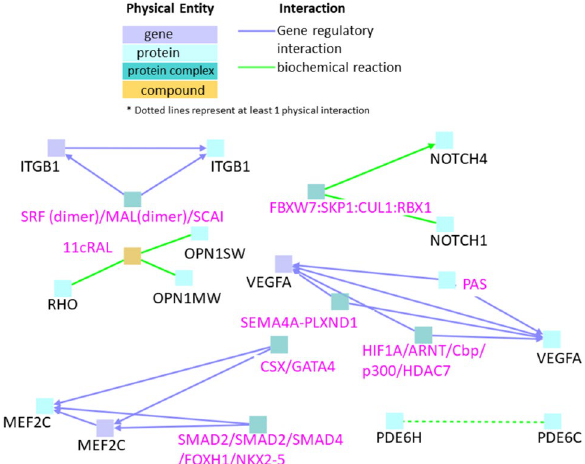
Figure 6. Interactions between genes that are downregulated exclusively in cardiotoxicity. Black labels denote seed nodes and pink labels denote intermediate nodes. Each line represents an interaction. Dotted line represents at least one physical interaction.